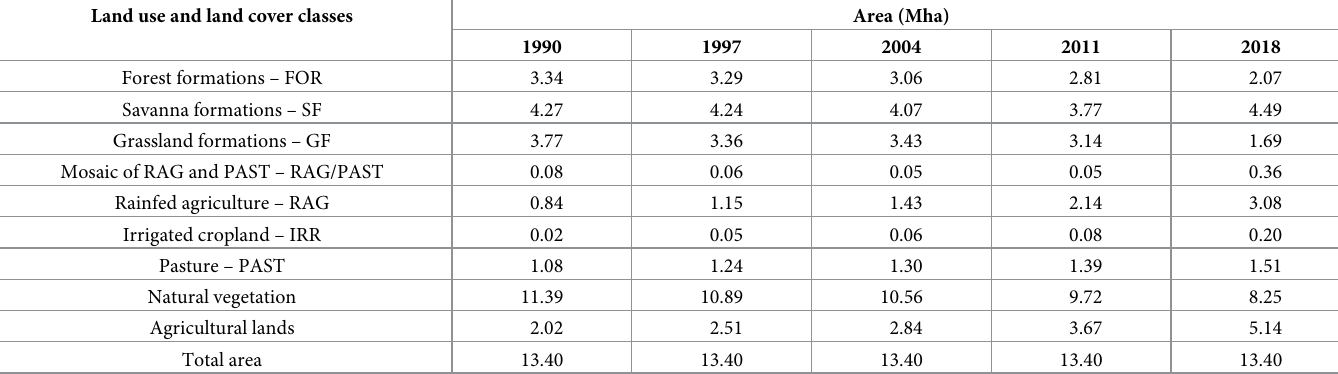
Table 1. Distribution of land use and land cover areas in Western Bahia in 1990, 1997, 2004, 2011, and